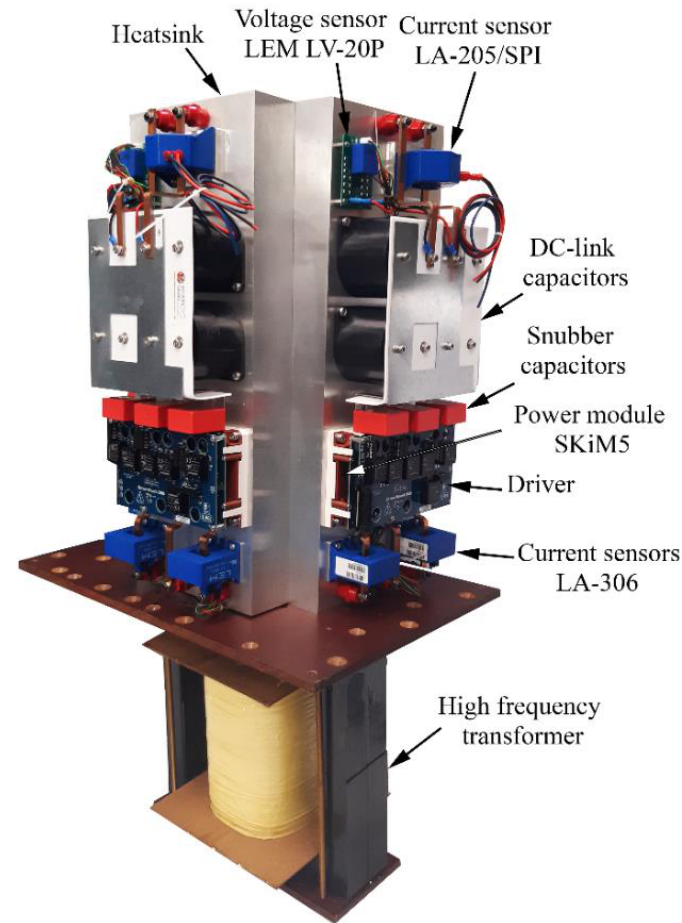
Figure 13. Prototype of the multi-port DAB charging station.